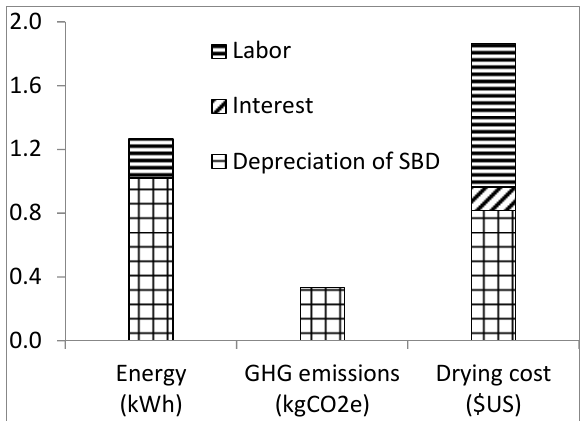
Figure 7. Energy efficiency, GHG emissions, and cost for drying 1 kg (dry product) of oyster Figure 7. Energy e ffi ciency, GHG emissions, and cost for drying 1 kg (dry product) of oyster mushroom. mushroom.